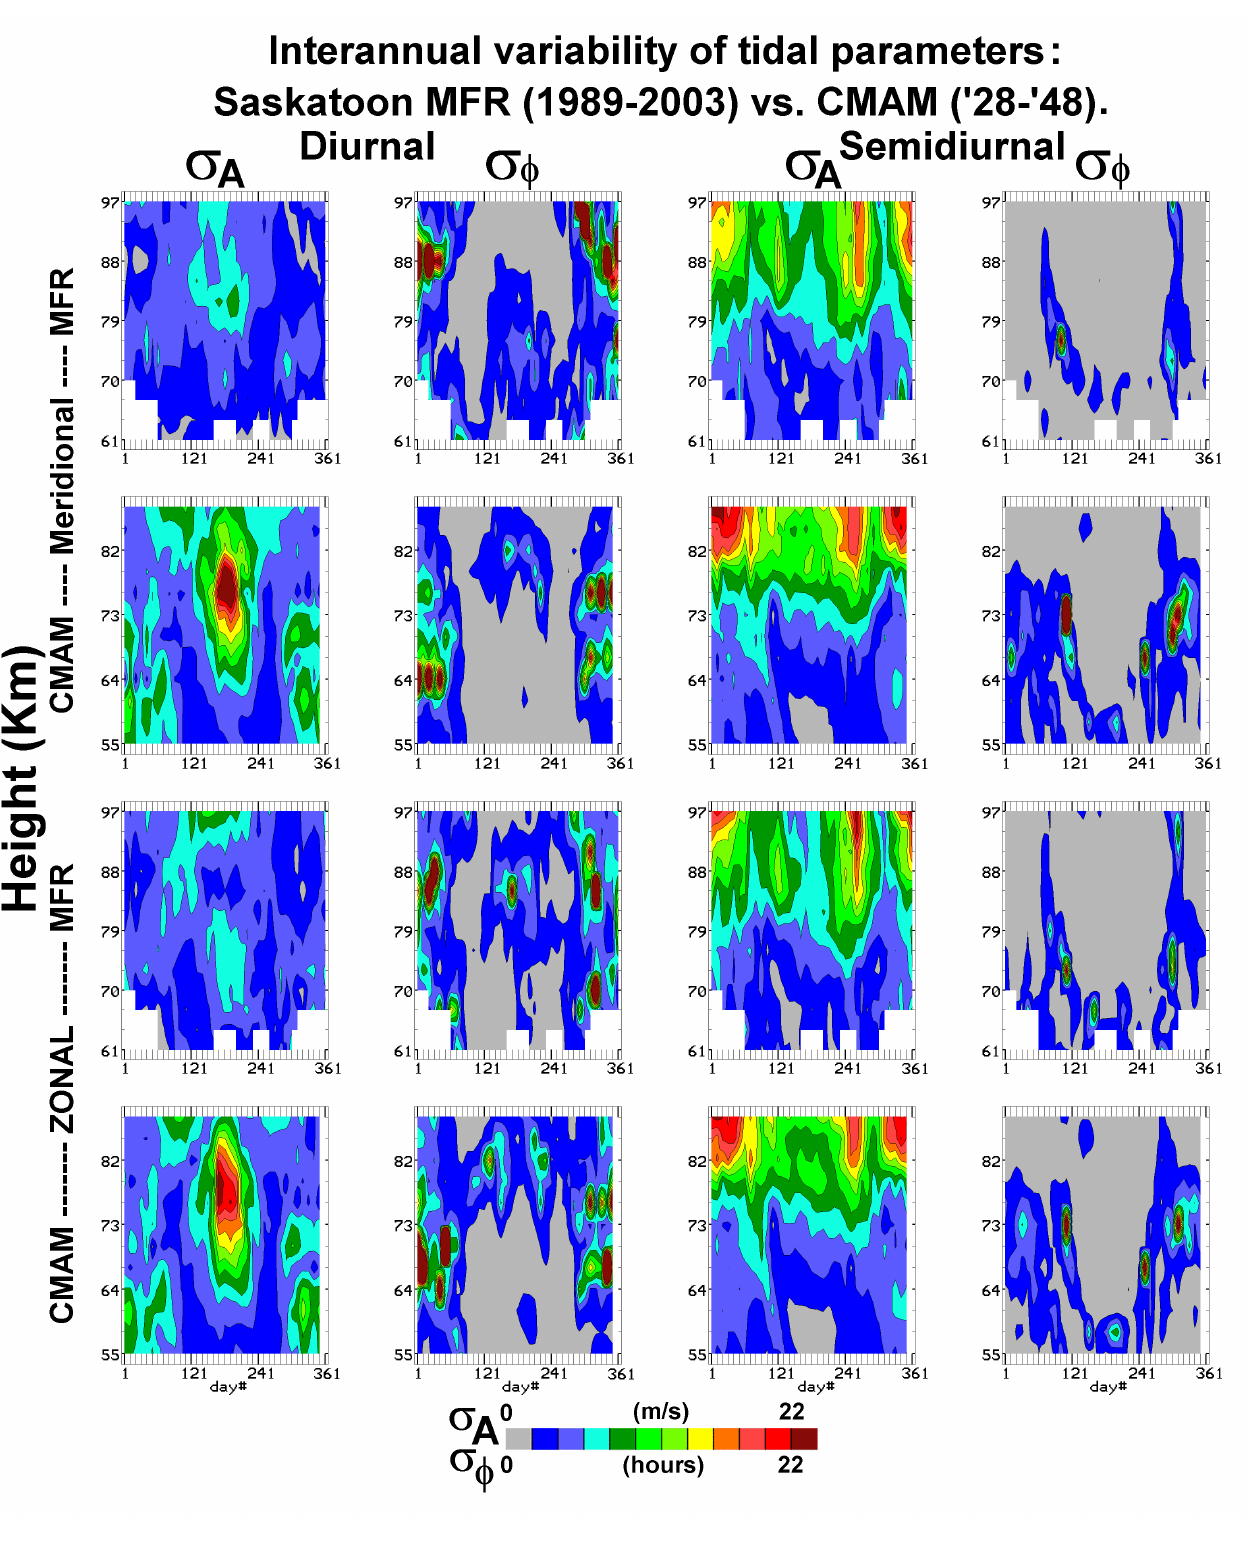
Fig. 10. Interannual variability of tidal parameters as represented by the standard deviations of the tidal (24-, 12-h) amplitudes and phases for both components (zonal, meridional) and for CMAM and the MFR at Saskatoon 52 ◦ N: 21 years of CMAM are used, and 15 years of MFR. Zonal (EW) and meridional (NS) components are